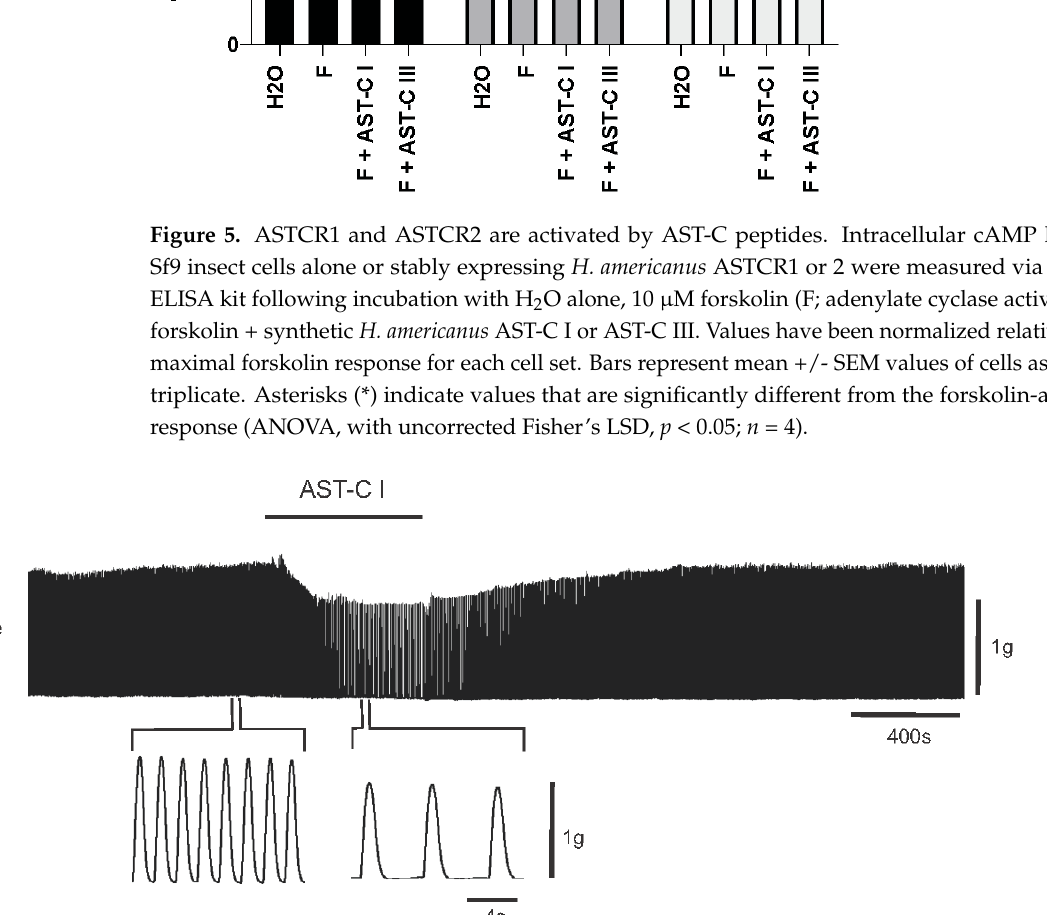
Figure 5. ASTCR1 and ASTCR2 are activated by AST-C peptides. Intracellular cAMP levels in Sf9 insect cells alone or stably expressing H. americanus ASTCR1 or 2 were measured via a cAMP ELISA kit following incubation with H 2 O alone, 10 µM forskolin (F; adenylate cyclase activator), or forskolin + synthetic H. americanus AST-C I or AST-C III. Values have been normalized relative to the maximal forskolin response for each cell set. Bars represent mean +/- SEM values of cells assayed in triplicate. Asterisks (*) indicate values that are significantly different from the forskolin-activated response (ANOVA, with uncorrected Fisher’s LSD, p < 0.05; n = 4).